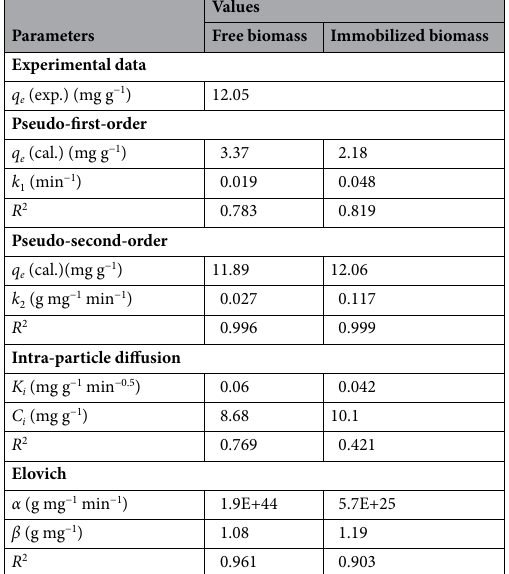
Table 3. Kinetic parameters for Cd 2+ biosorption with the free and immobilized T. ornata